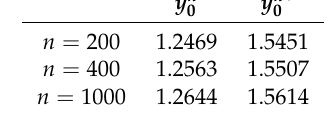
( τ = 0.7) and ˜ y n ∗ 0 0